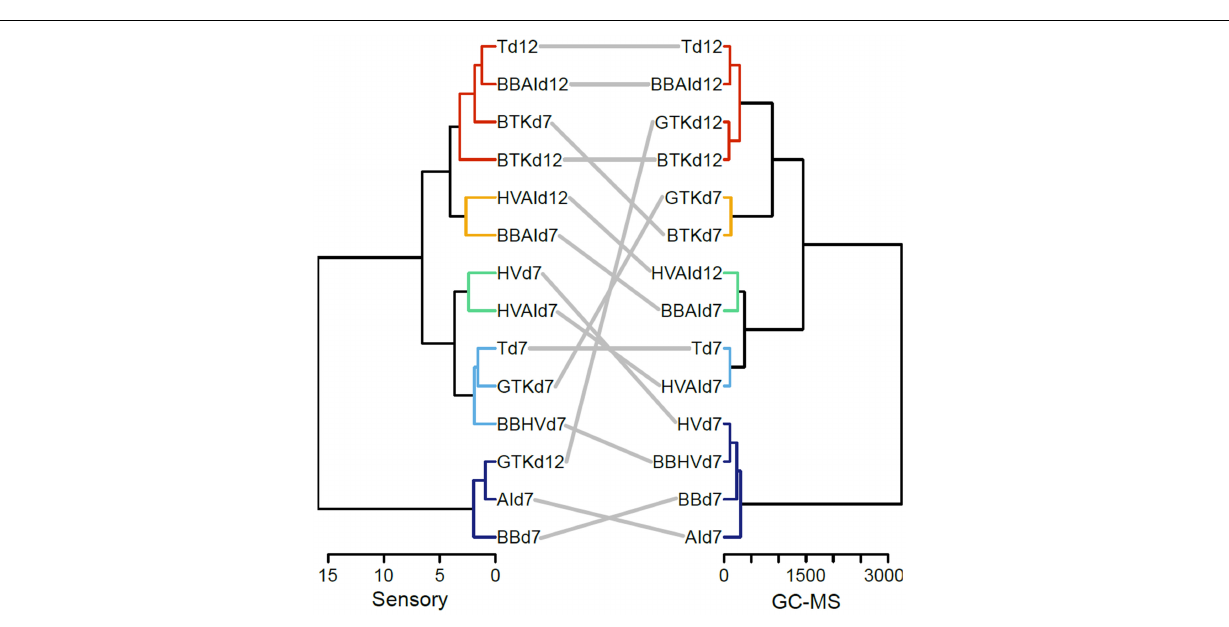
FIGURE 4 | Dendrogram comparison based on Ward clustering performed on sensory scores (left) and volatile metabolite concentrations (right) in the 32 detected metabolites among the 14 cultures evaluated by sensory